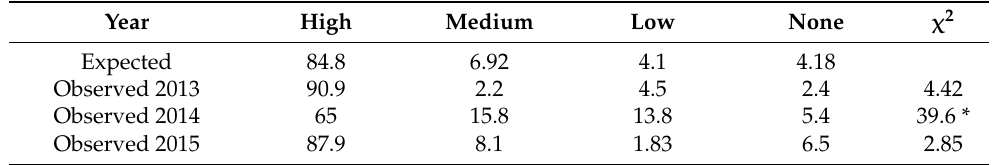
Table 3. Chi-square ( χ 2 ) analysis for woody cover suitability model verification based on historic ocelot GPS relocations from the East Foundation’s El Sauz Ranch. Recent ocelot GPS relocations from 2016 to 2020 were used in the moving window analysis as the expected dataset for this analysis. Tabulated χ 2 values > 7.81 ( α = 0.05, df = 3) indicate a statistical difference (*) in suitability model and observed location data from ocelots. Year High Medium Low None χ 2 Expected